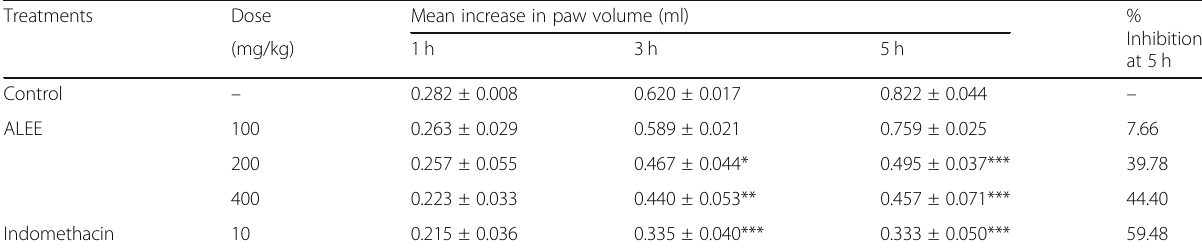
Table 3 Anti-inflammatory effect of ALEE on carrageenan-induced rat paw oedema Treatments